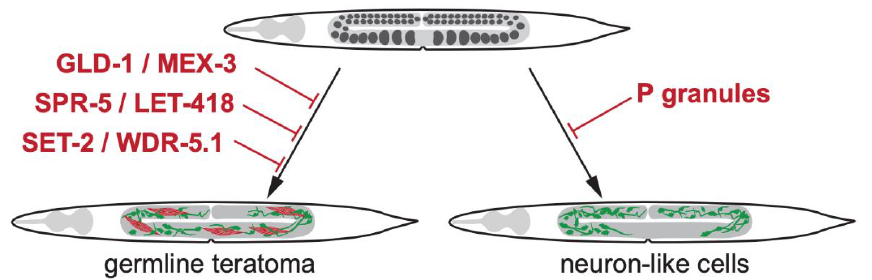
Figure 1. Loss of germline totipotency and teratoma formation. Upon loss of the translational regulators GLD-1 and MEX-3 germ cells differentiate to somatic cells thereby forming germline teratomas with co-occurrence of multiple somatic lineages at once including muscle, neuron and intestine [1]. Loss of the chromatin regulators SPR-5/LET-418 [8] and SET-2/WDR-5.1 [12] also result in germline teratomas. Loss of germline P granules leads to differentiation of germ cells to neuron-like cells, which do no acquire neuronal sub type identities [2].